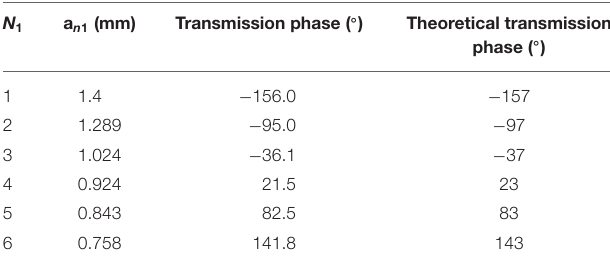
TABLE 1 | Deflection 22.92 ◦ array unit selection.